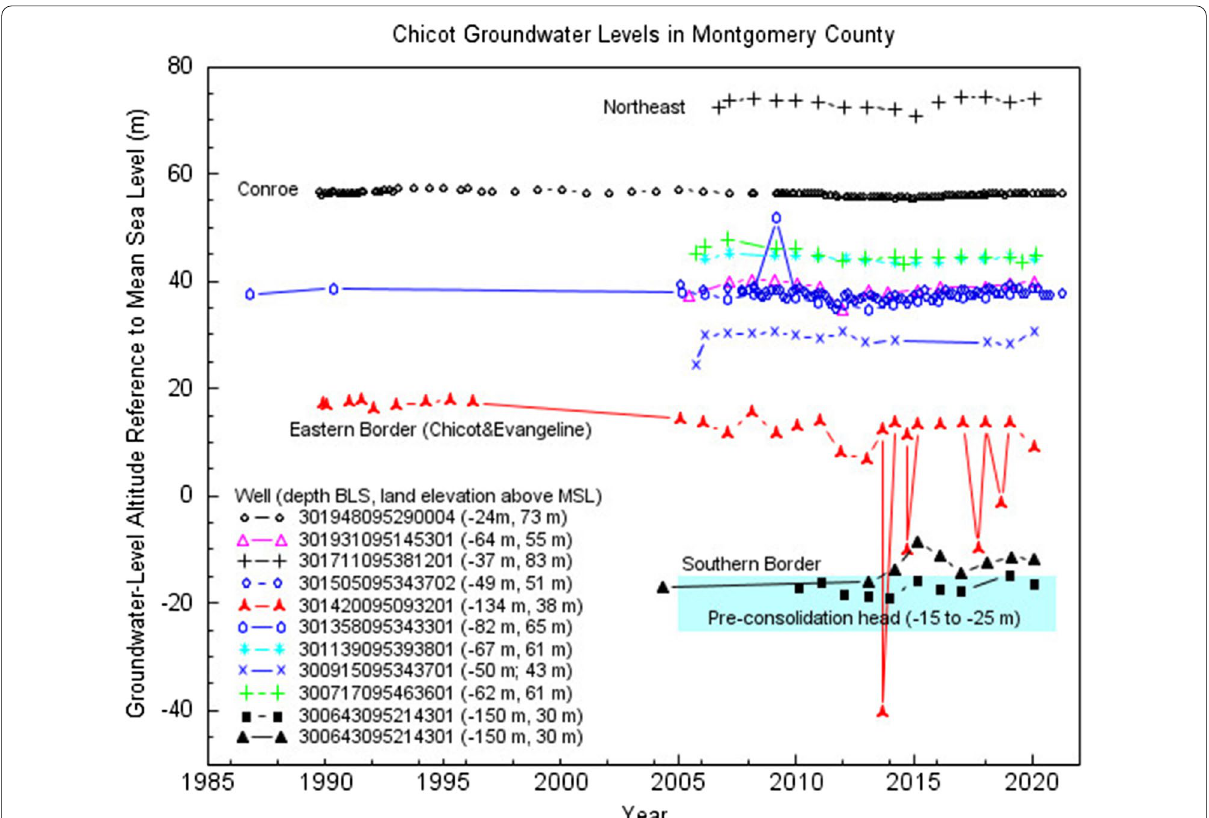
Fig. 6 Groundwater levels in 11 wells completed in the Chicot aquifer in Montgomery County. In the legend, “30194809529004 ( indicates USGS well number, well depth below land surface (BLS), and the elevation of land surface reference to mean sea level (MSL). The locations of these wells are marked in Fig.